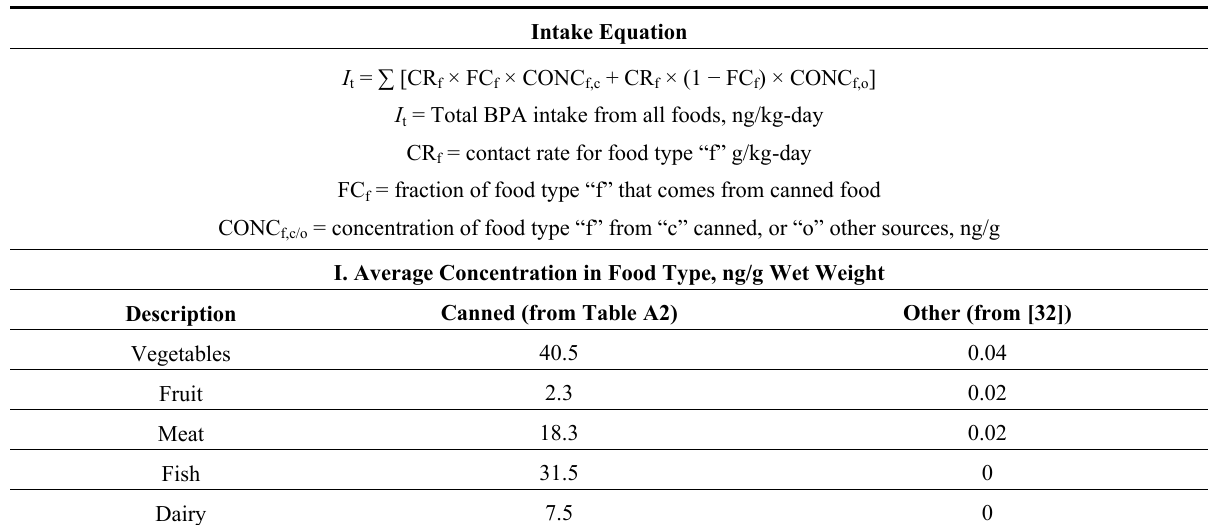
Table 2. Bisphenol A (BPA) intake from food, recalculated using three studies for canned food concentrations. Concentrations in canned food are an average of the following studies: [32], US; [31], US; [34],